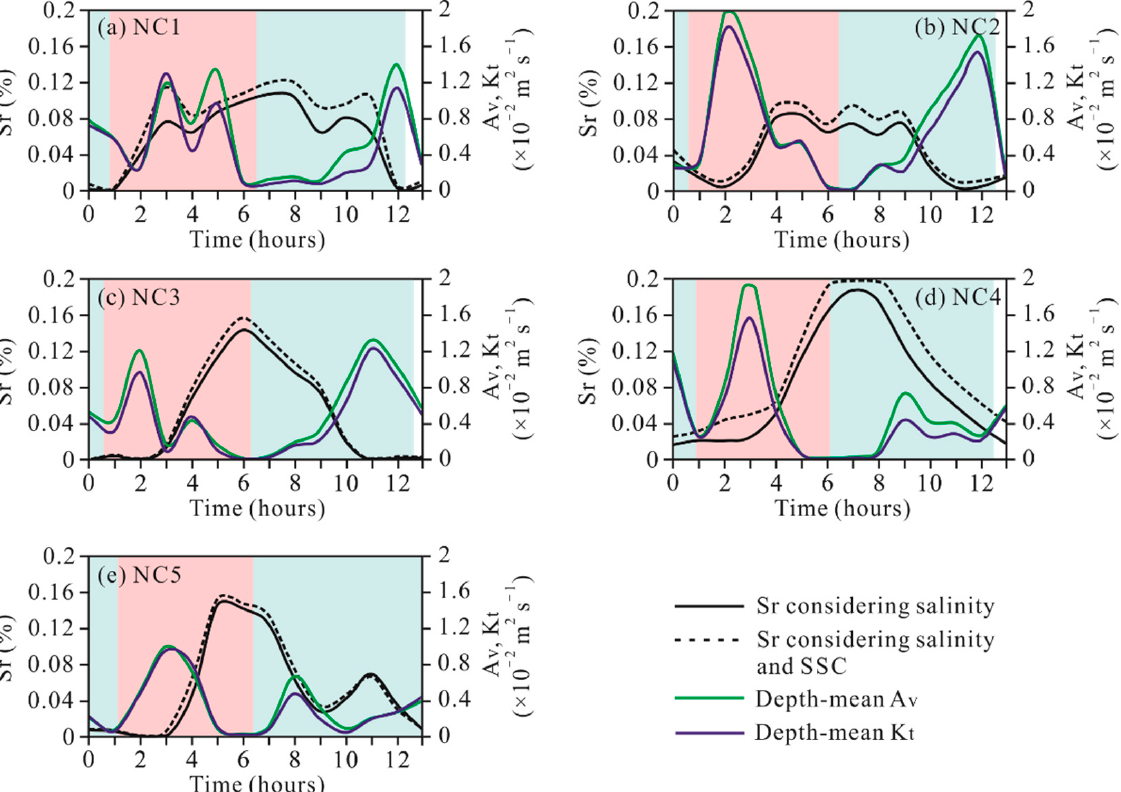
Figure 5. Temporal variations of stratification ratios S r (%) considering impacts of SSC and salinity and considering the impact of salinity only, the depth-averaged eddy viscosities A v (m 2 s − 1 ) and depth-averaged eddy diffusivities K t (m 2 s − 1 ) at NC1 to NC5 stations ( a – e